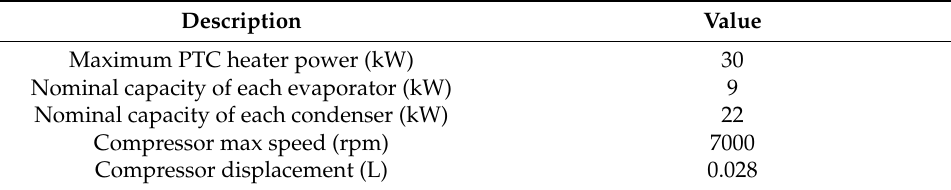
Table 5. HVAC system